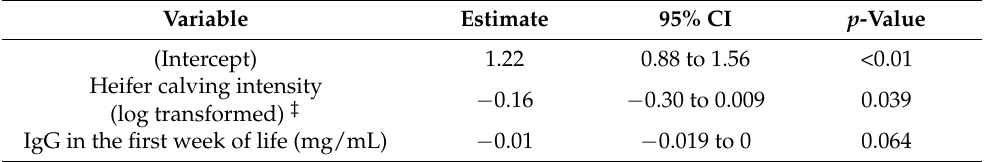
Table 2. Results of the linear mixed effects model for the composite diarrhoea score over the threshold for diagnosis in dairy heifers ( n = 492 on 11 farms) in their first nine weeks of life. Variable Estimate 95% CI p -Value (Intercept) 1.22 0.88 to 1.56 <0.01 Heifer calving intensity − 0.16 − 0.30 to 0.009 0.039 (log transformed) ‡ IgG in the first week of life (mg/mL) − 0.01 − 0.019 to 0